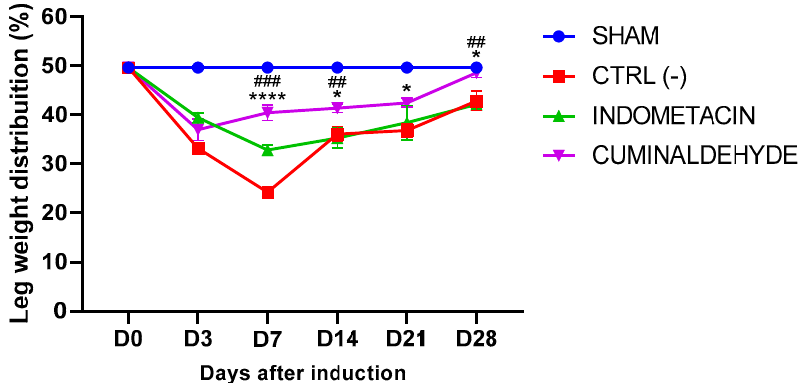
Figure 2. Effects of cuminaldehyde on the extent of disability in rats with induced osteoarthritis (OA), evaluated using the weight bearing test. The results are expressed as means ± standard error of the means (SEM). The healthy group (SHAM) represents animals without osteoarthritis or any treatment. The statistical analysis, conducted using two-way ANOVA followed by Tukey’s test, revealed significant differences ( p < 0.05) between cuminaldehyde-treated animals and both the saline group (CTRL-) and the indomethacin (positive control) group at D7, D14, and D28. The symbol * indicates significant differences compared to the saline group, and the symbol # indicates significant differences compared to the indomethacin group. Furthermore, the symbol **** represents p < 0.0001, ## represents p < 0.01, and ### represents p < 0.001. (D = day).